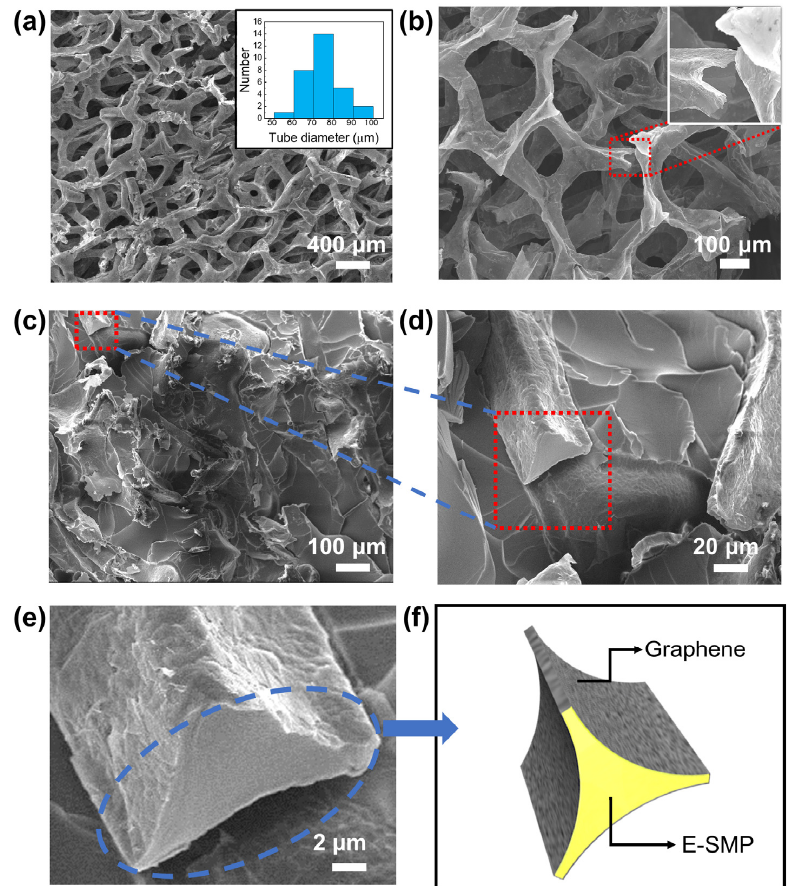
Figure 2. SEM images of ( a ) a graphene foam sample with histogram of tube diameter, ( b ) the cross-section of the foam with thin-walled hollow structures, ( c – e ) the cross-section of a GF-SMP sample after tensile fracture, and ( f ) schematic diagram of ( e